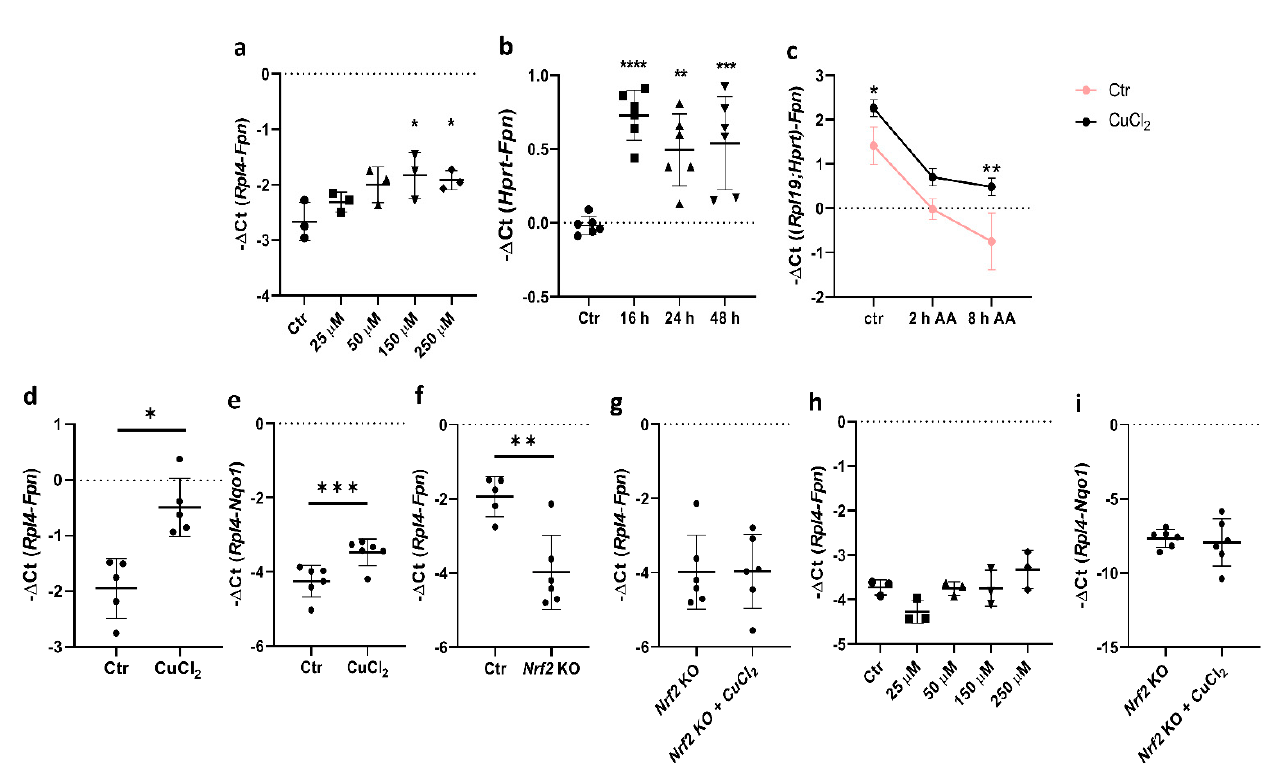
Figure 2. Copper loading affects Fpn transcription in BMDMs. ( a ) qPCR analysis of Fpn mRNA expression in BMDMs after 16 h exposure to various CuCl 2 concentrations. Data represent mean ± SD,* p < 0.05. ( b ) qPCR analysis of Fpn mRNA expression in BMDMs after exposure to 150 µ M CuCl 2 for 16, 24, and 48 h. Data represent mean ± SD, ** p < 0.01, *** p < 0.001, **** p < 0.0001. ( c ) qPCR analysis of Fpn mRNA expression in BMDMs after 16 h exposure to 150 µ M CuCl 2 followed by 2 and 8 h incubation with 2 µ g/mL α -amanitin. Data were normalized to expression level of two reference genes, Rpl19 and Hprt. Results presented as mean ± SD, * p < 0.05, ** p < 0.01. ( d , e ) qPCR analysis of Fpn and Nqo1 mRNA expression in BMDMs after 16 h exposure to 150 µ M CuCl 2 . Data represent mean ± SD,* p < 0.05,*** p < 0.001. ( f ) qPCR analysis of Fpn mRNA expression in BMDMs derived from wild-type and Nrf2 knockout mice after 16 h exposure to 150 μ M CuCl 2 . Data represent mean ± SD, ** p < 0.01. ( g–i ) qPCR analysis of Fpn and Nqo1 mRNA expression in BMDMs derived from Nrf2 knockout mice after 16 h exposure to 150 μ M CuCl 2 . Data represent mean ± SD. Graph in ( h ) reflects Fpn mRNA expression level in Nrf2 knockout BMDMs after 16 h exposure to various CuCl 2 concentrations.